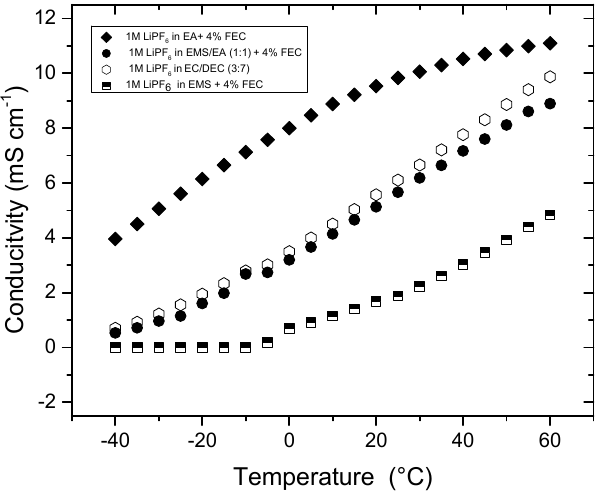
Figure 3. Conductivity measurements of 1 M LiPF 6 in EMS + 4% FEC, 1 M LiPF 6 in EA + 4% FEC as well as 1 M LiPF 6 in EMS:EA (1:1) + 4% FEC and 1 M LiPF 6 in EC/DEC (3:7), in the temperature range from − 40 ◦ C to 60 ◦